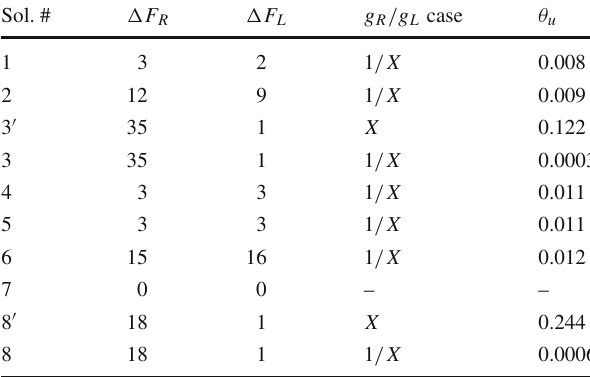
Table 5 Scenarios of anomaly-free Z (cid:3) –models and the mixing angle θ u for different charge assignments taken from Table 6. The primed solutions are RH-dominated, whereas the unprimed ones are LH- dominated Sol. #